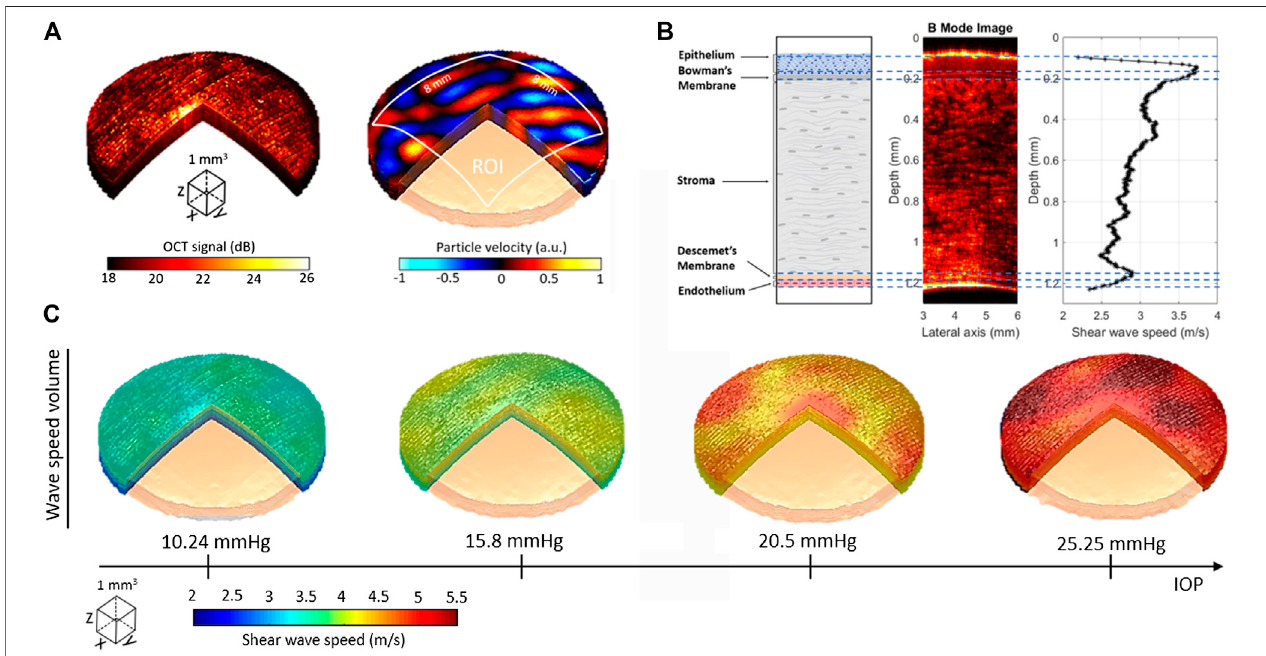
FIGURE9| Elastography of ex vivo porcinecorneas using OCT-RSWE. (A) StructuralOCT(left)and motion (particle velocity,right) volumes obtained inthecornea subjected to reverberant fi eld of 2 kHz. (B) Average depth-dependent shear wave speed pro fi le of cornea compared with intensity changes of the B-mode structural information and the anatomical description of corneal layer. 3D shear wave speed volumes (in m/s) of cornea subjected to four different IOP levels: 10.24, 15.80, 20.50, and 25.25 mmHg. Reprinted by permission from Springer Nature from Ref. 16.